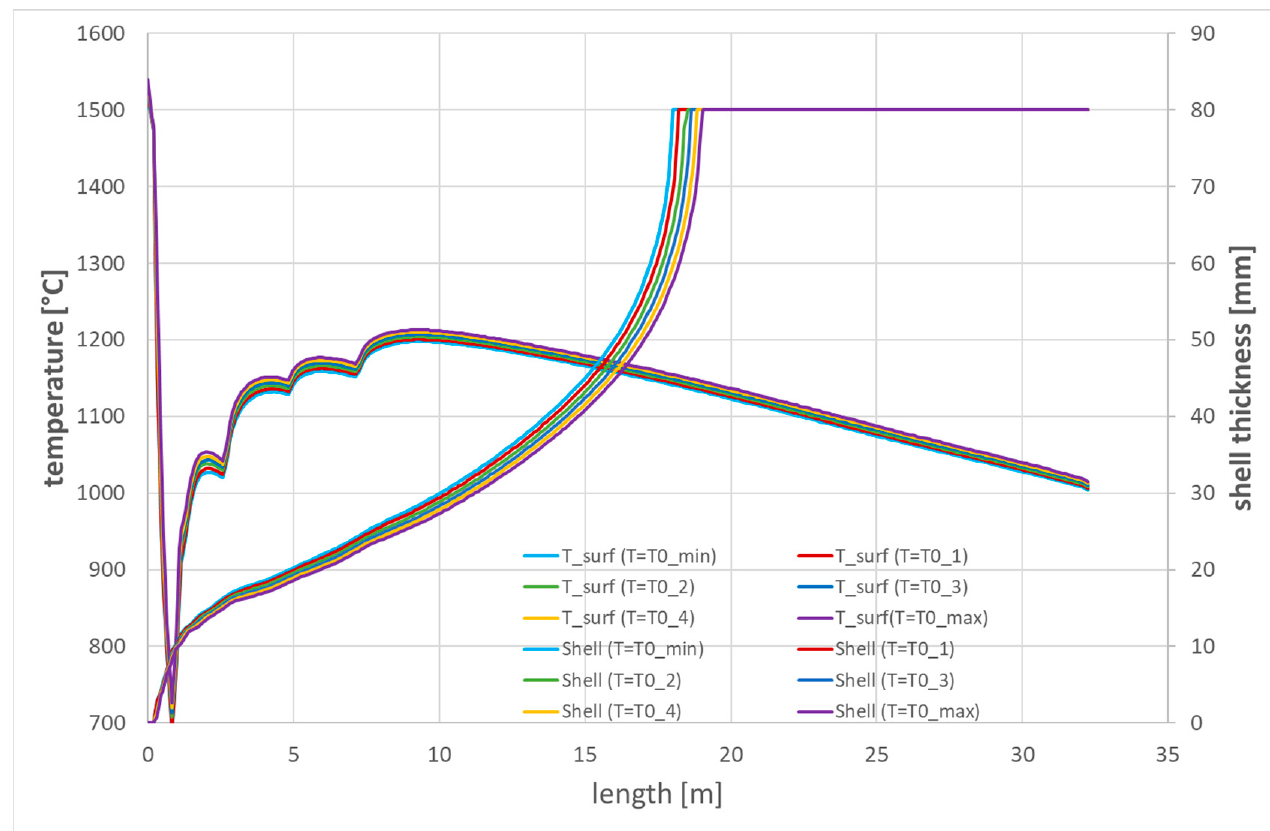
Figure 14. Surface temperature and shell thickness for the middle of the strand top side simulated with DynSolidCC for billet casting at ESF with stationary reference casting conditions and variation of initial steel temperature between T 0min and T 0max .